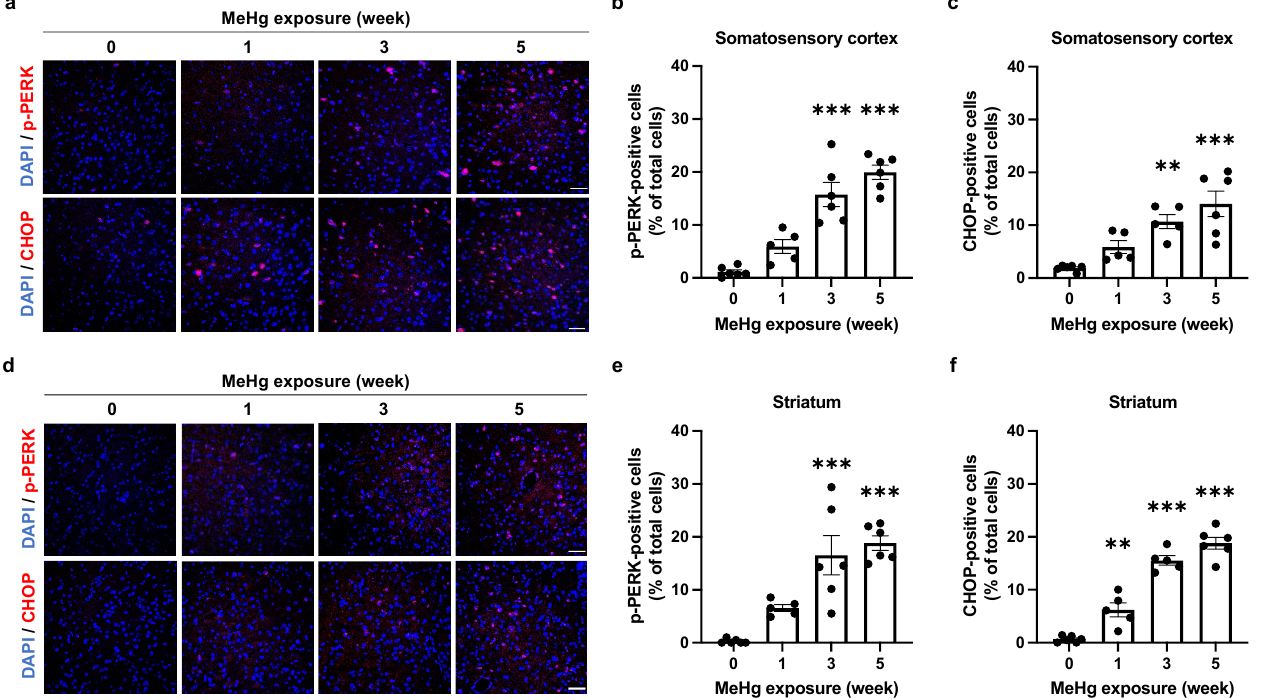
Figure 4. Effect of MeHg exposure on PERK branch in the mouse brain. ( a , d ) Detection of p-PERK and CHOP in the somatosensory cortex ( a ) or striatum ( d ) of ERAI-Venus mice exposed to MeHg for the indicated times. Each scale bar represents 50 μm. ( b , e ) Quantification of p-PERK-positive cells in the somatosensory cortex ( b ) or striatum ( e ). ( c , f ) Quantification of CHOP-positive cells in the somatosensory cortex ( c ) or striatum ( f ). Data are expressed as the mean ± S.E.M. values (n = 5 – 6, ** p < 0.01, and *** p < 0.001: significant difference compared with control mice without MeHg exposure (0 weeks) by one- way ANOVA with Dunnett’s post hoc test).